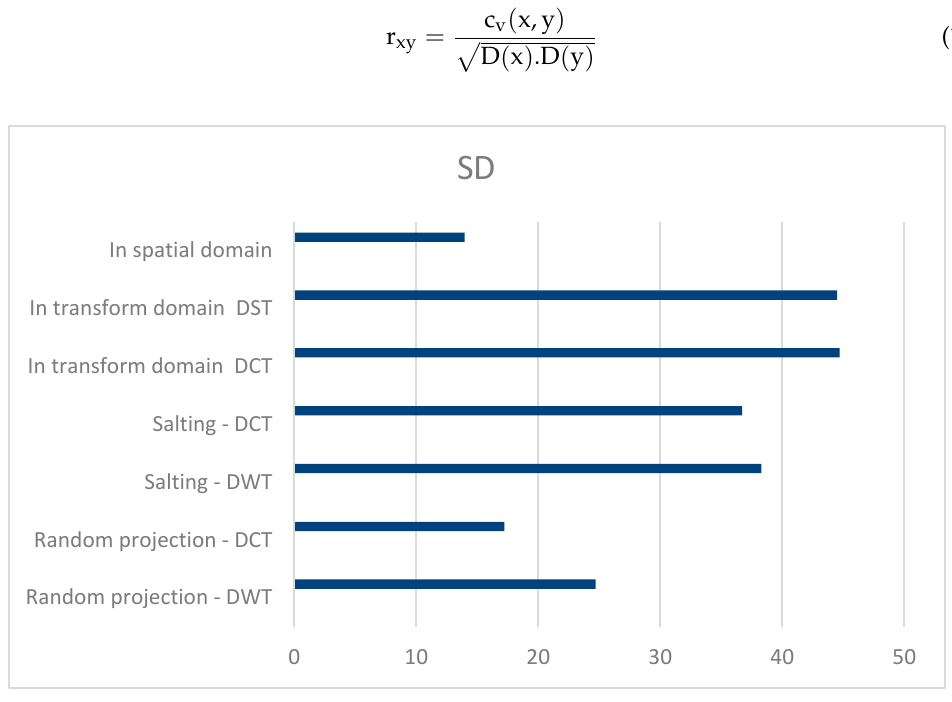
Figure 9. Comparison of SD values for the proposed cryptosystem.